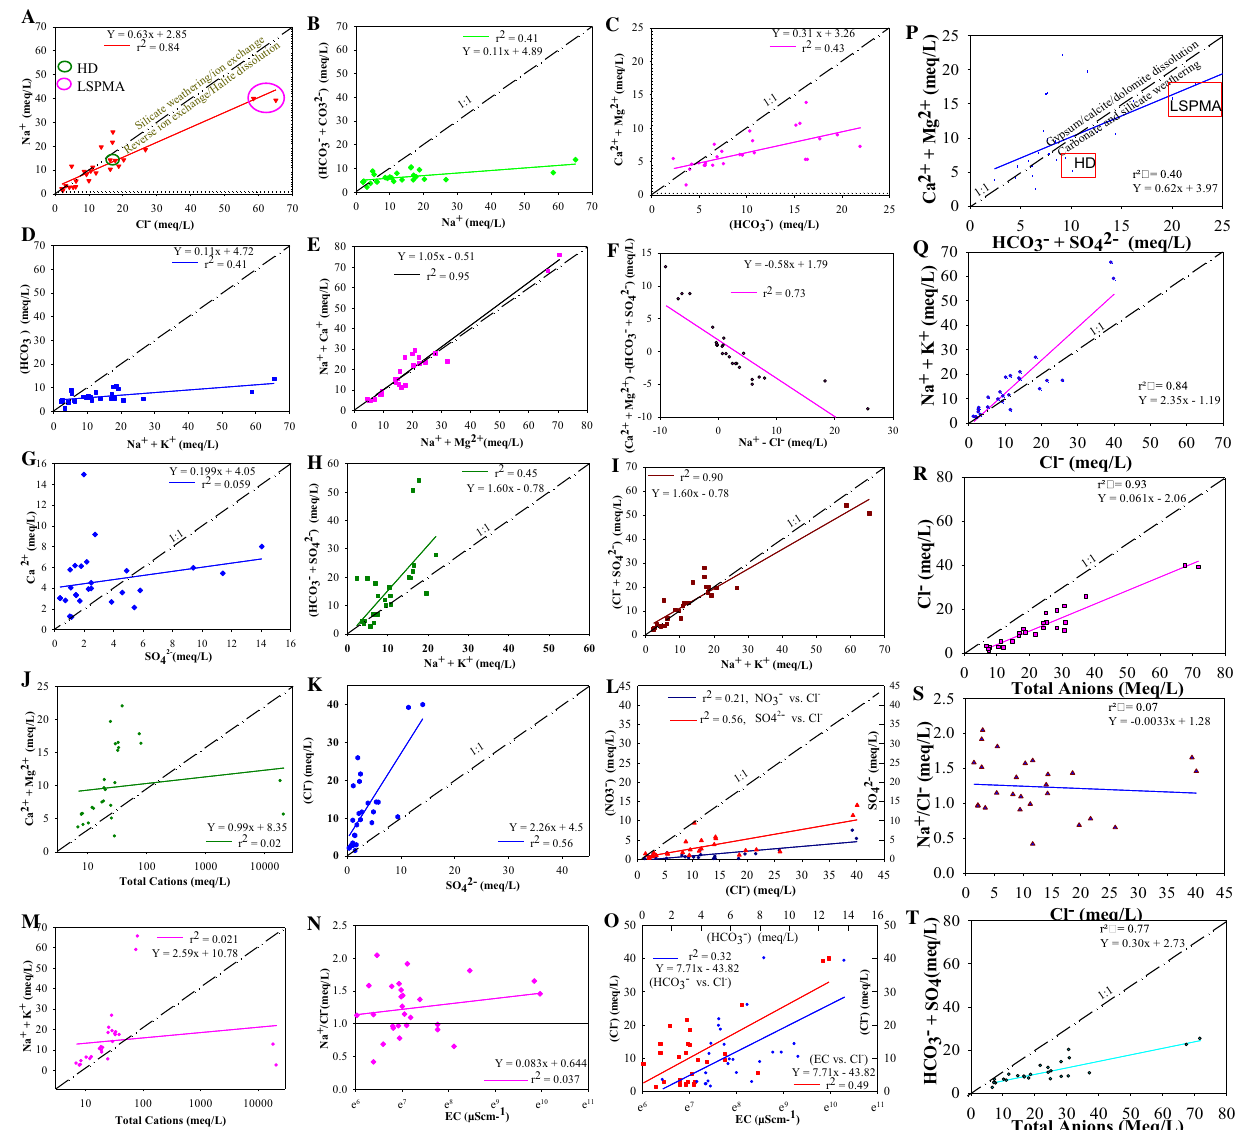
Fig. 6 Ionic relationships and ratios of the major local anions and cations in water sources from Hombolo dam catchment, Tanzania. The dash- dotted lines represent equilines